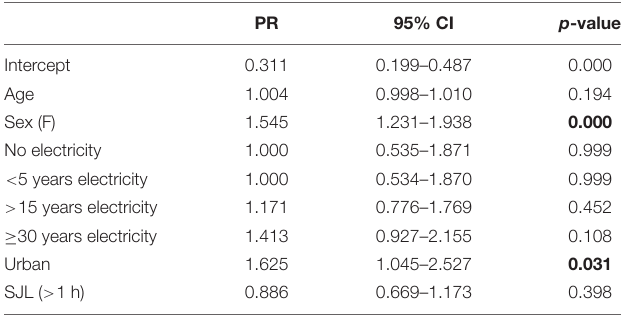
TABLE 2 | Poisson regression (model 1): variables derived from questionnaires associated with overweight or obesity ( N = 244). PR 95% CI